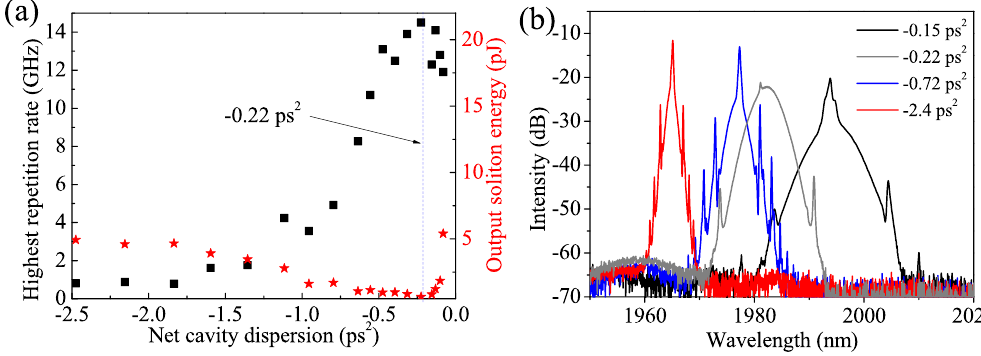
Figure 4. ( a ) Highest repetition rate of stable HML and corresponding soliton energy at different net cavity dispersions, and ( b ) optical spectra at the net dispersion of − 0.15 ps 2 , − 0.22 ps 2 , − 0.72 ps 2 , and − 2.4 ps 2 .